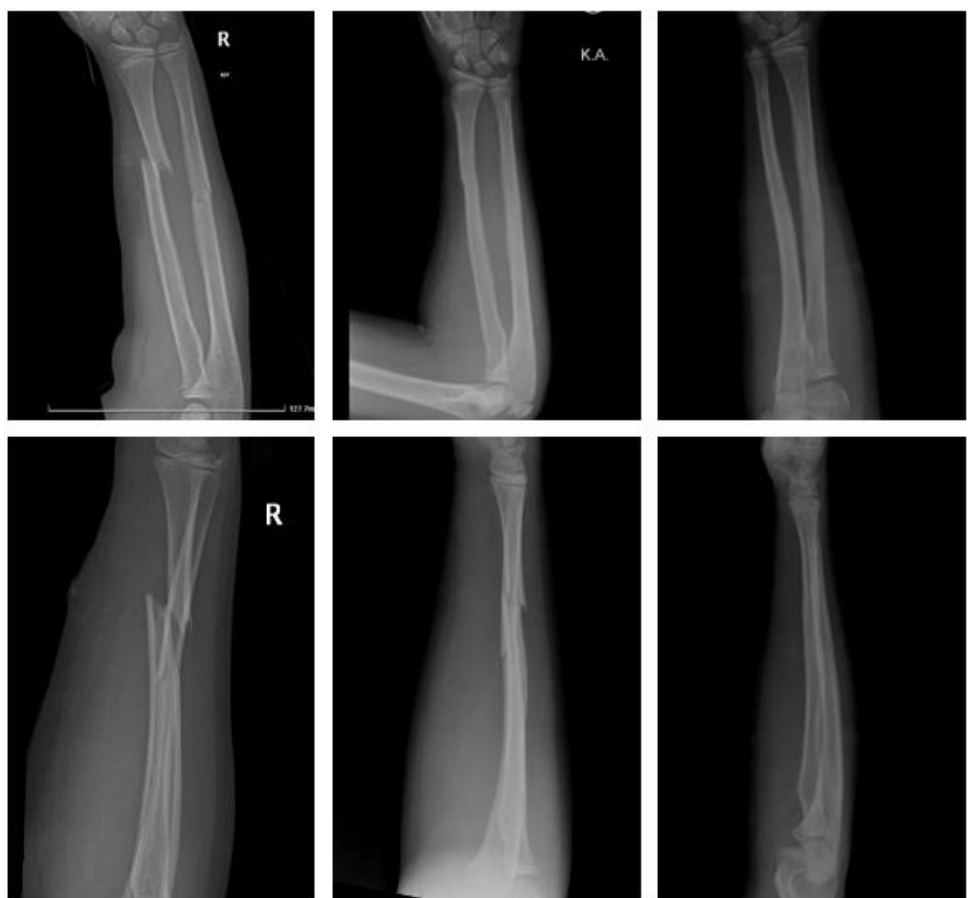
Figure 8. Forearm shaft fracture with Activa IM-Nail TM : preop, same day postop, 6 months postop (left to right).